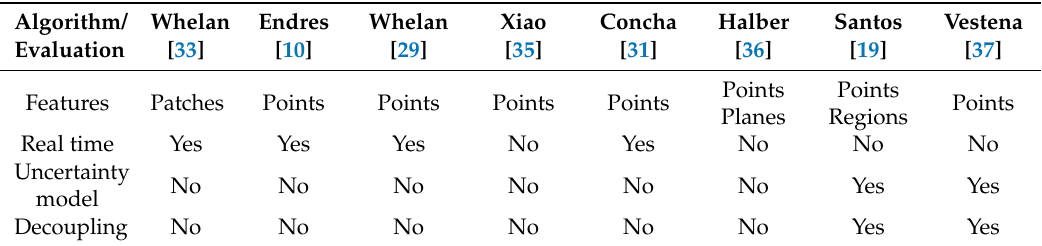
Table 1. Comparisons of related works in terms of feature types, running time, depth uncertainties, decoupling rotation and